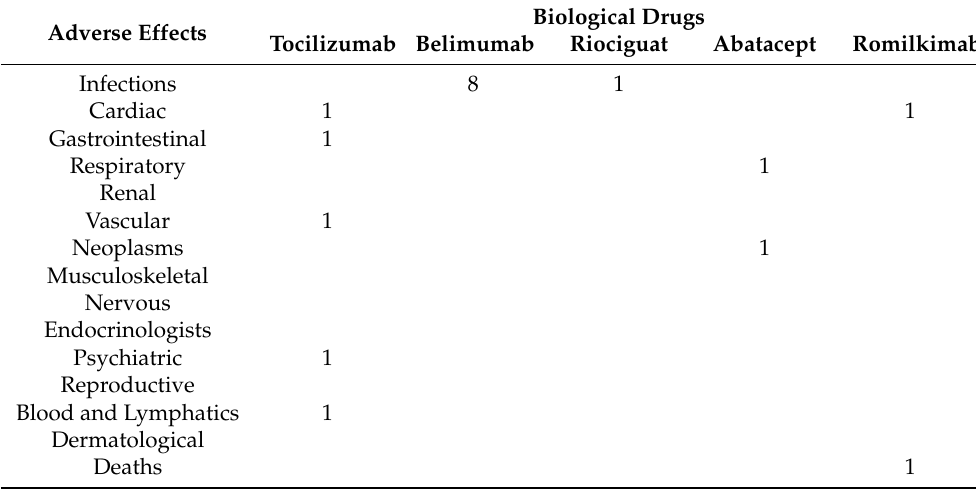
Table 6. Number of adverse effects of biological drugs in the intervention group. Adverse